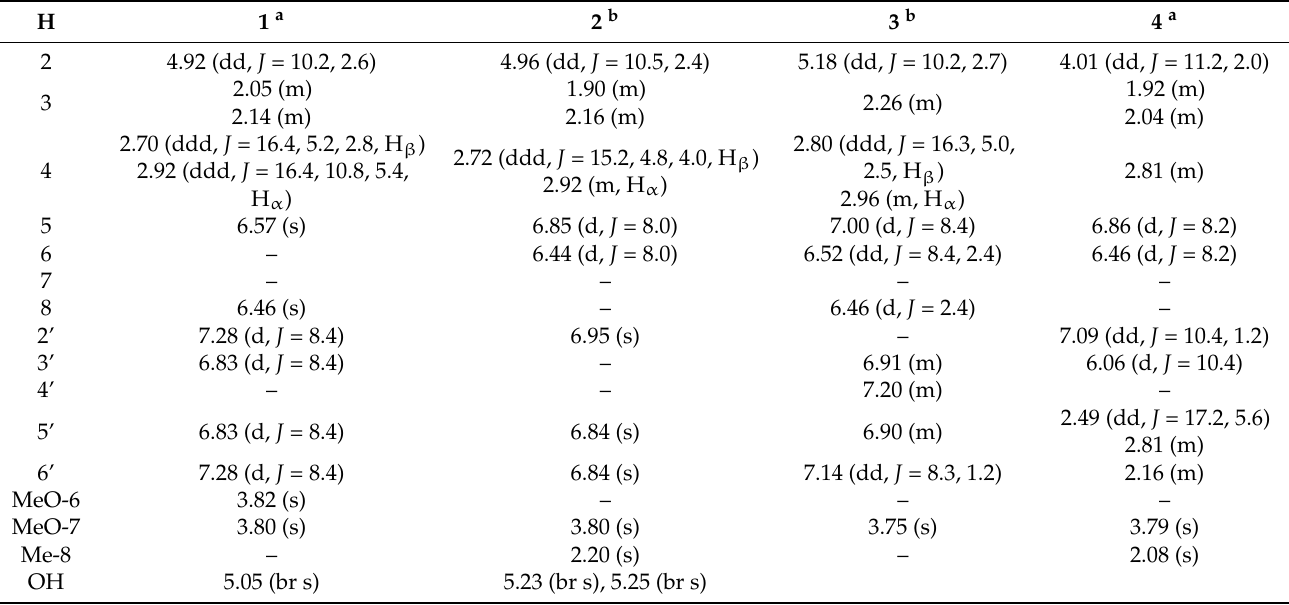
Table 1. 1 H-NMR data (CDCl 3 ) of compounds 1 – 4 . Chemical shifts δ in ppm, J in Hz.